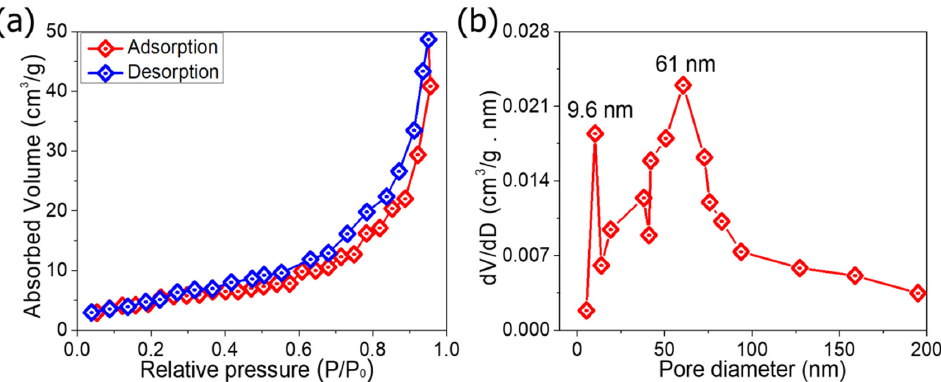
Figure 4. ( a ) N 2 adsorption and desorption isotherms; ( b ) pore-size distribution of ZnCoO@NF. The XRD pattern of ZnCoO@NF (Figure 5a) is well-indexed according to the standard spinel phase ZnCo 2 O 4 (JCPDF# 23-1390). The particular diffraction peaks of ZnC 2 O 4 located at 21°, 32°, 37°, 39°, 44.7°, 56°, 59.5°, and 66° correspond, respectively, to 111, 220, 311, 222, 422, 511, and 440 lattice planes. Compared with the standard ZnCo 2 O 4 spinel, these results are consistent with the previous findings [20]. The lattice plane of 400 at 44.7° is overlapped with the XRD peak of NF. No other impurities are detected except two intense peaks from the NF at 45° and 52.5° of 2 θ , demonstrating the high purity of the sample. The JCPDF# 23-1390 of pure Co 3 O 4 was added as a comparison to confirm the difference between ZnCo 2 O 4 and Co 3 O 4 . The diffraction peaks of as-prepared ZnCoO@NF clearly matched with JCPDF# 23-1390 and confirm the pure phase of ZnCo 2 O 4 . The crystal structure ZnCo 2 O 4 nanostructures are shown in Figure 5b. Binary spinel metal oxide ZnCo2O 4 with Co 2+ at the tetrahedral sites (8a) in the spinel Co 3 O 4 replaced by Zn 2+ offers a better stability. In addition, the spinal structure can help increase the redox reaction sites, which boosts the specific capacitance of bimetallic oxide-based electrodes. Thus, choosing the bimetallic oxide and crystal structure is critical for overall performance and structural stability during the electrochemical discharge process [22]. The Raman spectrum further characterized the as-synthesized ZnCoO@NF to confirm the Raman band characteristics. From Figure 5c, the Raman spectrum of ZnCoO@NF demonstrates four active vibrational bands located at 183, 472, 513, and 682 cm − 1 assigned to the characteristic F 2g , E g , F 2g , and F 2g phonon modes, respectively. The presence of Zn, Co, and O in these distinct peaks of the Raman spectrograms suggests the formation of ZnCo 2 O 4 . This indicates that the prepared sample is free of contaminants [23]. The electrochemical performance results of ZnCoO@NF are shown in Figure 6. The CV was performed at various scan rates in a potential window ranging from 0.0 to 0.5 V. The CV curves indicate two redox peaks at approximately 0.38 and 0.42 V (vs Ag/AgCl), which represent the typical pseudocapacitive behavior of the ZnCoO@NF associated with Co 3+ /Co 2+ during the charge/discharge process [19]. The reduction peak shift is related to the internal resistance of the electrode materials, which further confirms the pseudocapacitive features with enhanced charge storage [24]. Moreover, the CV possesses a large area under the curve with high current response, indicating better charge storage behavior. The electrodes’ excellent redox reversibility can be seen in the redox peaks caused by reactions involving Co–O/Co–O–OH [25].